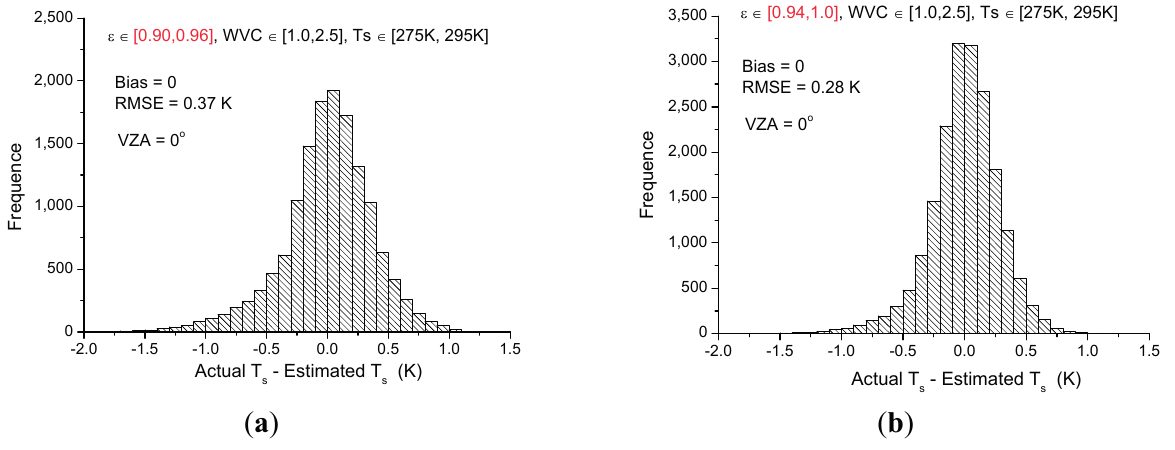
Figure 7. Histogram of the difference between the actual and estimated (cid:1846) sub-range of 1.0 g/cm 2 to 2.5 g/cm 2 and the LST sub-range of 275 K to 295 K for VZA = 0°. ( a ) (cid:2013) ∈ (cid:4670)0.90, 0.96(cid:4671) and ( b ) (cid:2013) ∈ (cid:4670)0.94, 1.0(cid:4671)